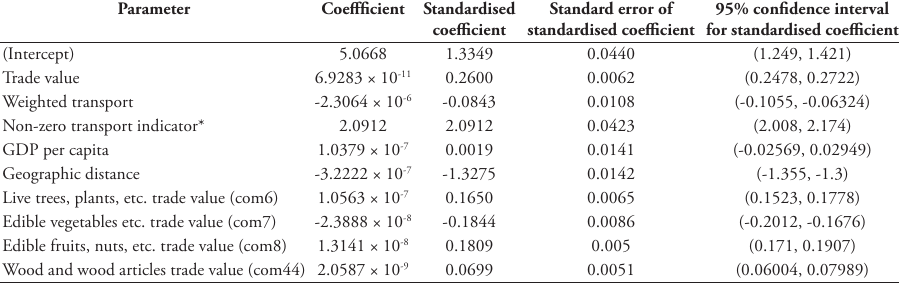
Table 5. Coefficients and standardized coefficients for the chosen model. Parameters com6, com7, com8, and com44 denote the total value of imports from the country into Australia of the given commodities: com6 for ‘Live plants, cut flowers, etc.’, com7 for ‘Edible vegetables’, com8 for ‘Edible fruit’, com44 for ‘Wood products’.